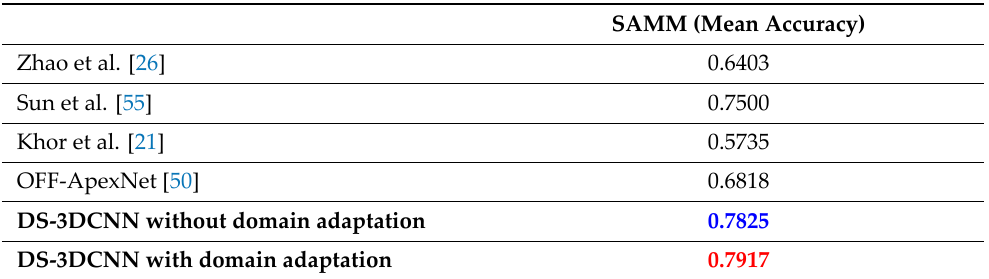
Table 5. Comparison of mean accuracy between two proposed models and other models on the SAMM dataset.